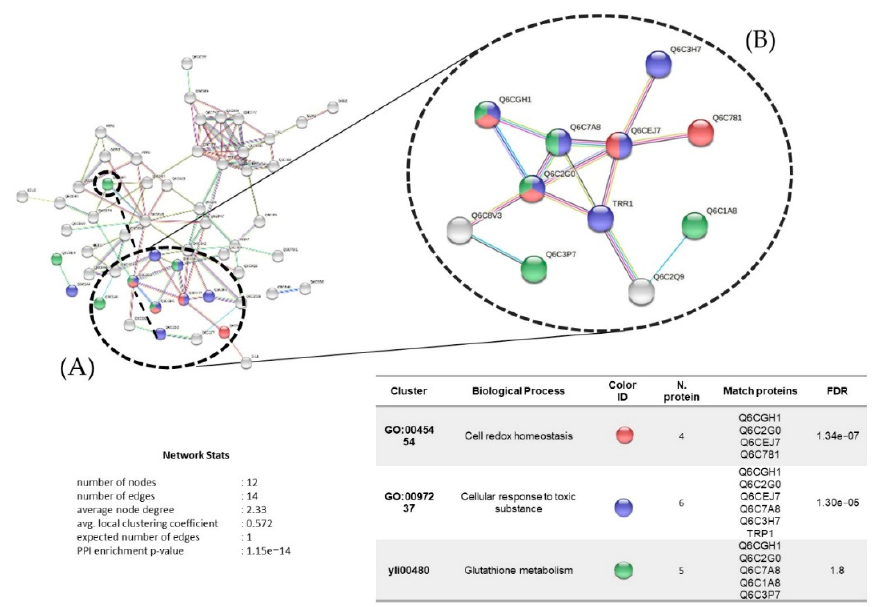
Figure 11. ( A ) Protein interaction networks (upregulated) of Y. lipolytica AMJ6 related to biological processes under chromium (Cr +6 ) treatment. ( B ) Proteins related to cell redox homeostasis, cellular response to toxic substances, and glutathione metabolism.